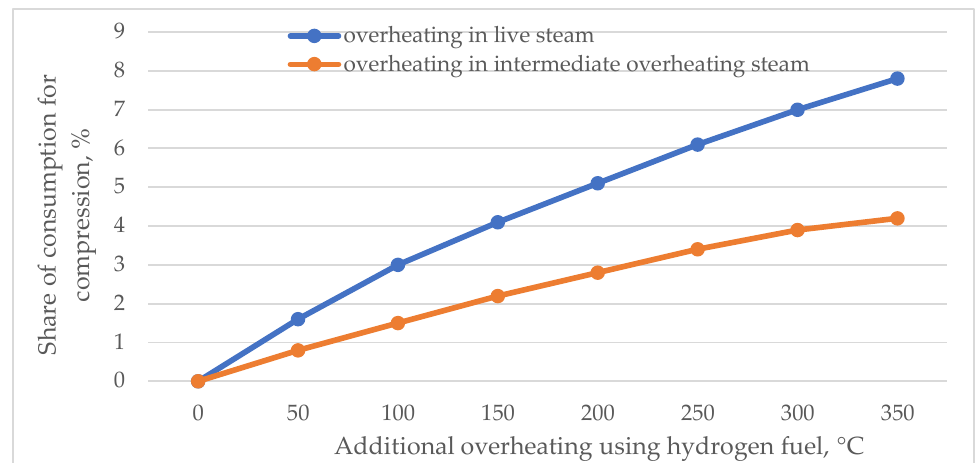
Figure 8. Share of additional power consumed for hydrogen and oxygen compression depending on the additional overheating using hydrogen fuel.